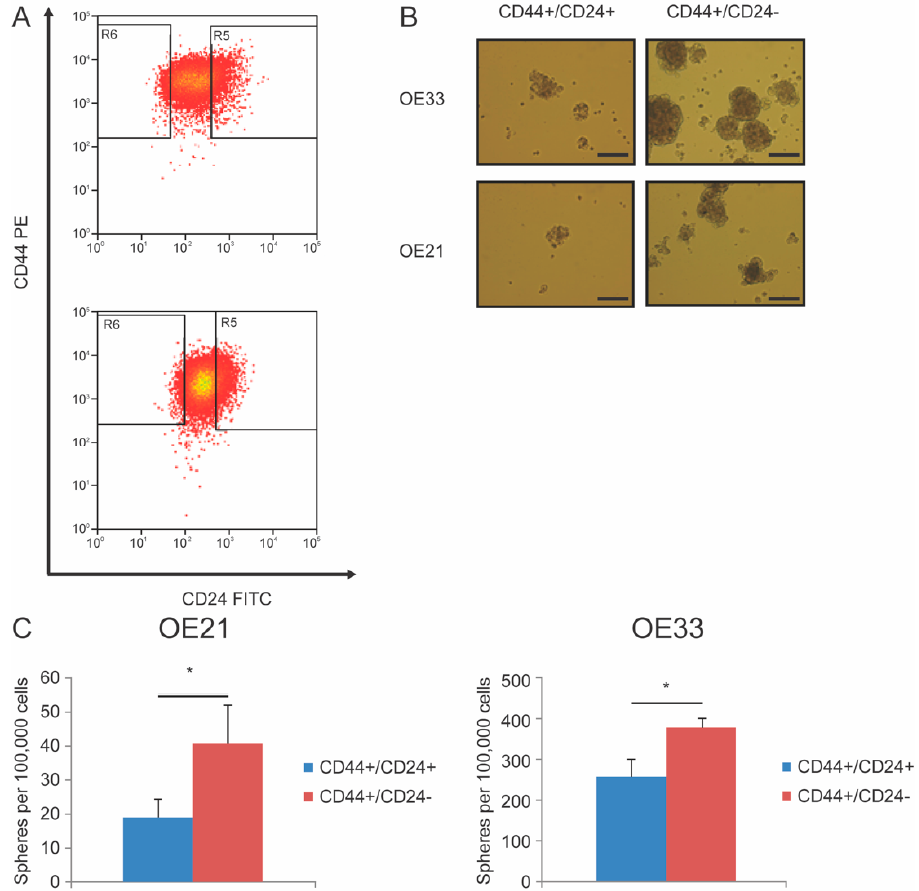
Figure 2. Enhancement of sphere formation capacity by sorting for CD44 +/ CD24 − . ( A ) Representative FACS plots of OE21 and OE33 stained with CD24 FITC and CD44 PE. ( B ) Representative images of spheres. Bar indicates 100 µ m. ( C ) Quantification of spheres shown in ( B ). OE21 CD44 +/ CD24 − vs. CD44 +/ CD24 + ( p = 0.01) and OE33 CD44 +/ CD24 − vs. CD44 +/ CD24 + ( p = 0.02, N = 3) spheres after five days of culture. Error bars represent standard deviation, * p < 0.05.